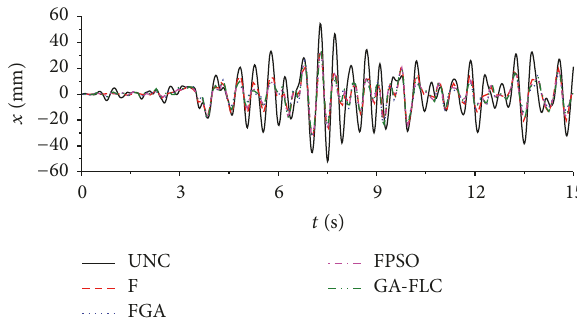
Figure 16: Top-layer displacement response curve under the action of the Taft wave.